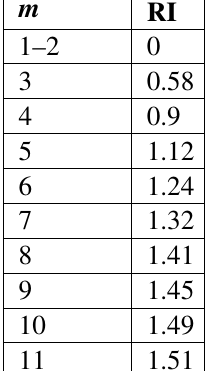
Table 4 Average random consistency index value standard